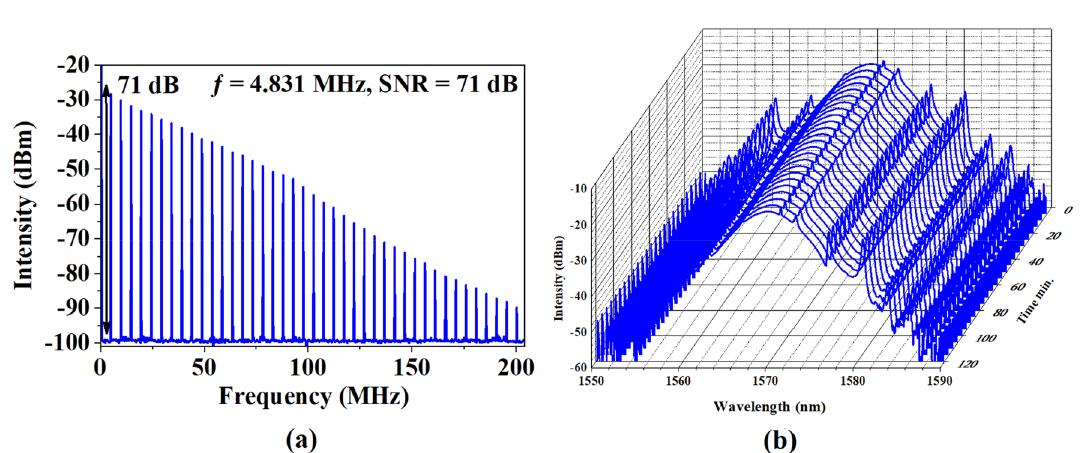
Figure 7. Mode-locked EDFL performance with 42.7 m cavity length ( a ) RF spectrum and ( b ) long-term